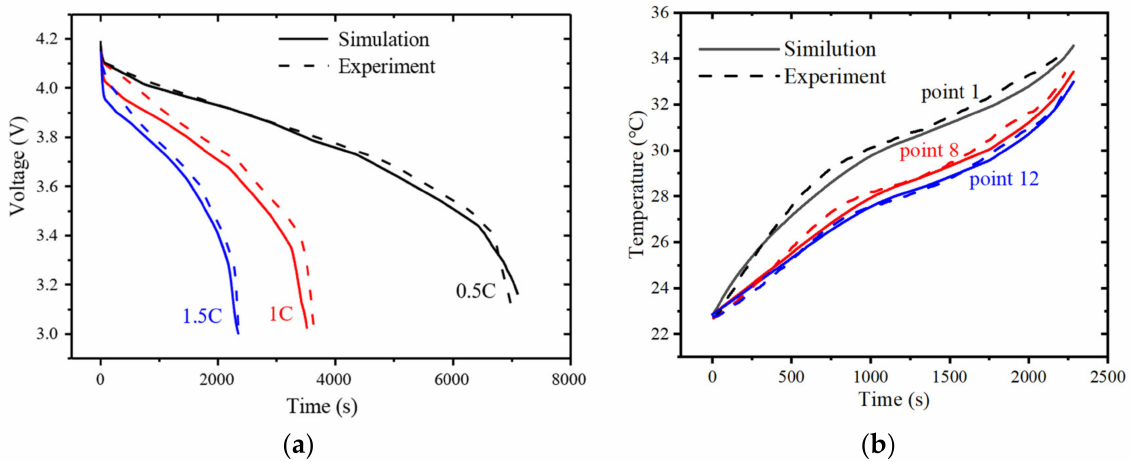
Figure 3. ( a ) Voltages of the cell during discharge at 0.5 C, 1 C and 1.5 C; ( b ) temperatures at point 1, point 8 and point 12 during discharge at 1.5 C.